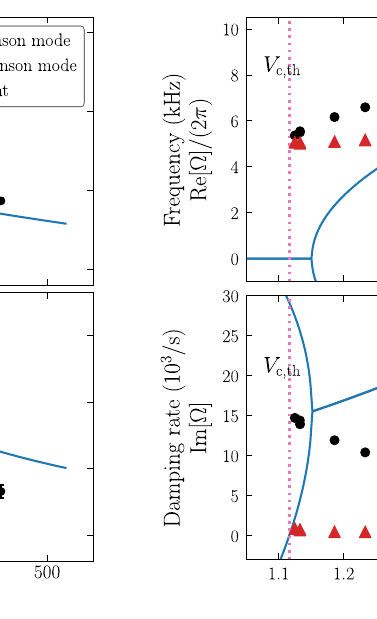
FIG. 13. Measured coherent frequency and damping rate as the functions of the cavity voltage. The beam current was 350 mA. The closed circles and the triangles indicate the fitted results for the broad and narrow peaks, respectively. The solid lines show the numerical solutions of Eq. (1) for the beam current of 350